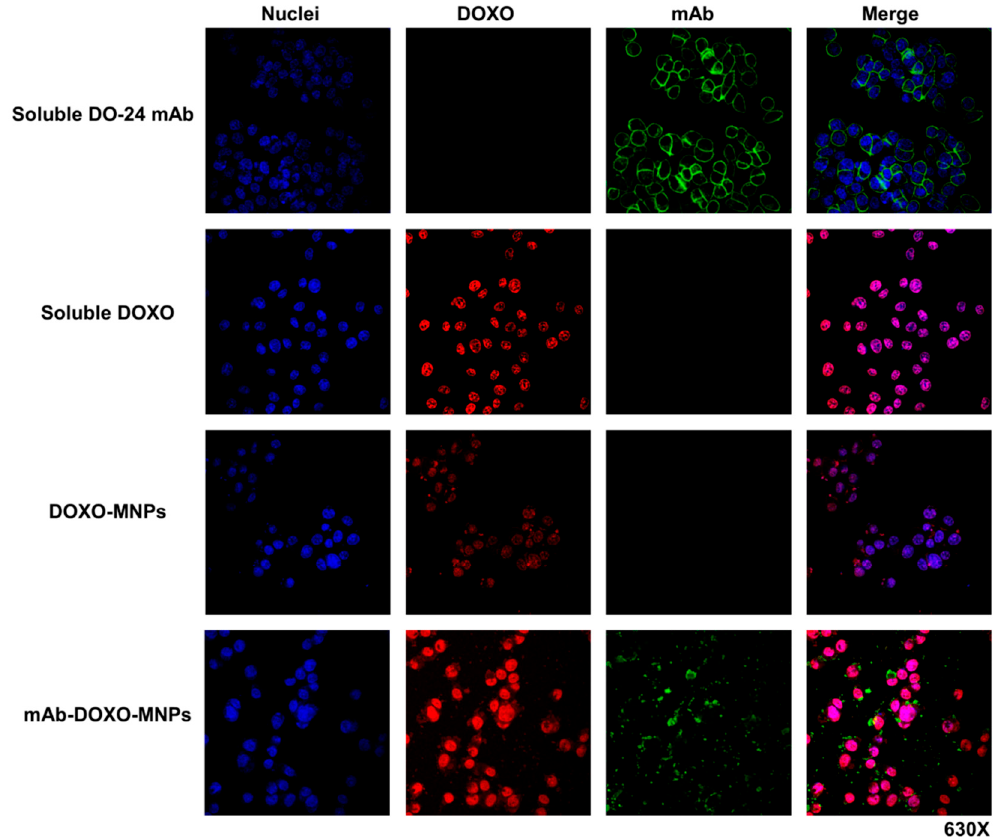
Figure 9. Interaction of mAb-DOXO-functionalized nanoparticles with GTL-16 cells. Cells were incubated with mAb-functionalized MNPs, carrying or not DOXO, as well as with soluble DOXO for 2 h at 37 °C. After washing, staining was performed with FITC-labelled anti-mouse Ig (green), TO-PRO3 (blue) to label the DO-24 mAb and nuclei, respectively. DOXO is detected as a red signal. Images were then merged.